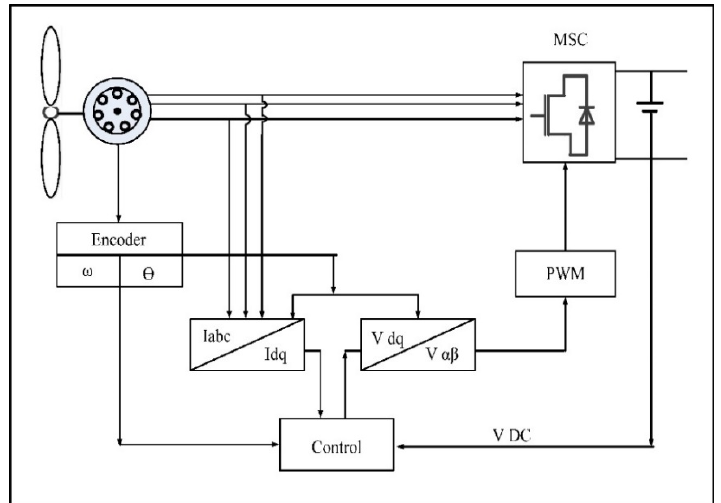
Figure 8. Machine side control block diagram.